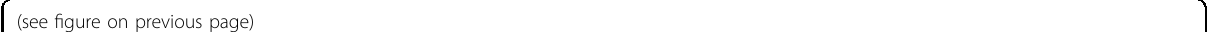
Fig. 5 Apoptotic response to X-rays, WS-12 or their combination in RWPE-1 based models of premalignant and malignant prostate lesions. a Diagram of the experimental design. Genetically engineered RWPE-1 cells were treated as indicated (BioRender.com). b Representative fl ow cytometry analysis of cell death in ERG + and ERG + /PTEN-de fi cient RWPE-1 M8 cells treated with WS-12 (1 μ M, 12 h), X-rays (10 Gy) or the combination of both. Untreated cells were used as control. c Cell death quanti fi cation of RWPE-1 M8 cells treated as described in b is reported as percentage of total cells. d Western blotting analysis of samples described in b shows CaMKII α activation (phosphorylation of Thr286) following WS- 12 treatment of RWPE-1 M8 and the classical molecular signature of apoptotic cell death (Caspase-3 and PARP cleavage) in RWPE-1 M8-based premalignant (ERG-shCTR) and malignant (ERG + shPTEN) models of human prostatic disease treated with X-rays plus WS-12. e Representative ERG + and ERG + /PTEN-de fi cient RWPE-1 M8 3D prostopheres treated with WS-12 (1 μ M, 12 h), X-rays (10 Gy) or the combination of both. Untreated spheroids were used as control. Scale bar, 50 μ m. f Western blotting analysis of treated prostopheres described in e showing classical molecular hallmarks of apoptotic cell death (Caspase-3 and PARP cleavage). Error bars, mean ± SD. Experiments were performed in quadruplicate; data were analyzed using a two-way ANOVA test. ** P ≤